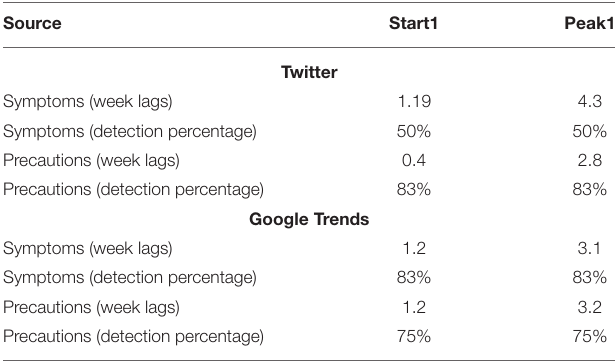
TABLE 2 | The average prediction value of Canadian provinces (with an early wave).